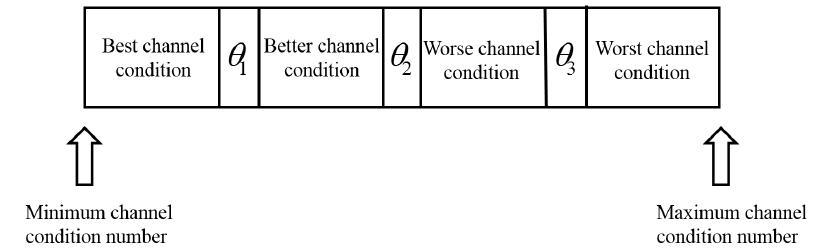
Figure 4. The relationship between the channel condition number and the